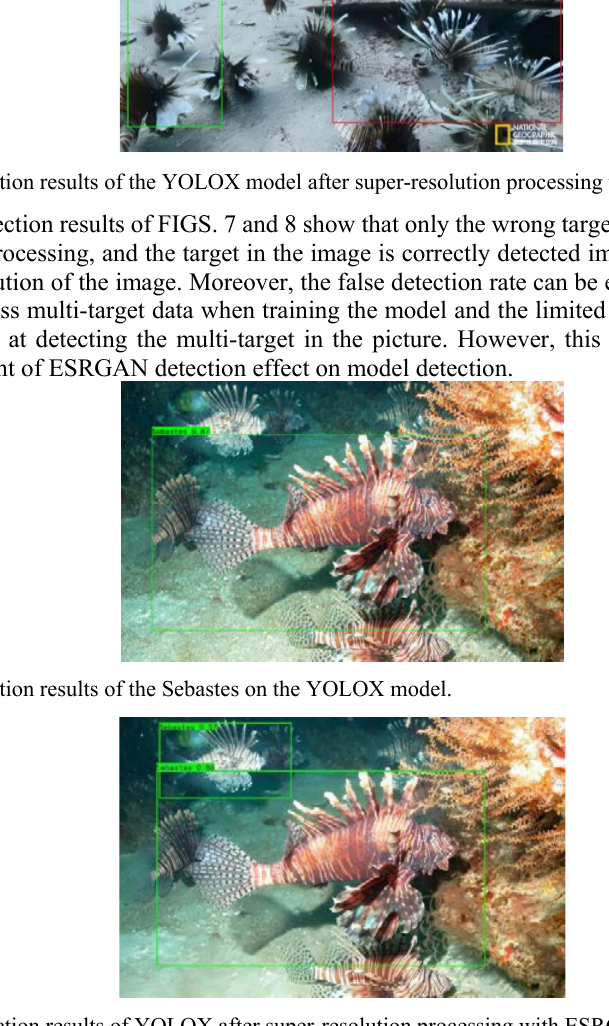
Fig. 10 Detection results of YOLOX after super-resolution processing with ESRGAN.